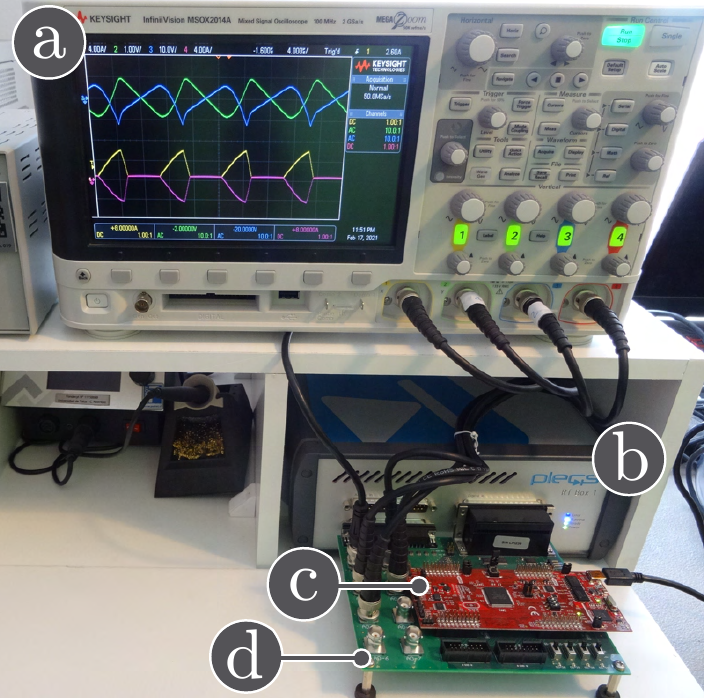
Figure 9. Hardware-in-the-loop experimental setup: ( a ) oscilloscope, ( b ) PLECS RT-box 1, ( c ) Texas Instruments LAUNCHXL-F28069M, ( d ) RT Box LaunchPad